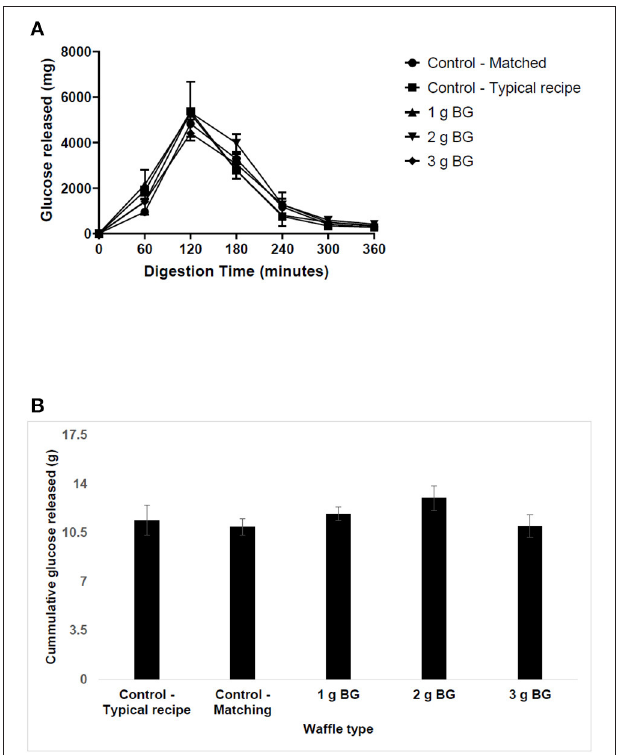
FIGURE 1 | The in vitro digestibility of waffle carbohydrates using TIM-1 digestion model. Waffles containing ∼ 15g of available carbohydrate were fed to the TIM-1 system and the dialysates were collected from jejunum and ileum compartments every 60min for glucose analysis after acid hydrolysis. The data represent mean ± SD ( n = 2). (A) The release of glucose in hydrolysates over time. (B) Total carbohydrate released over 360min of